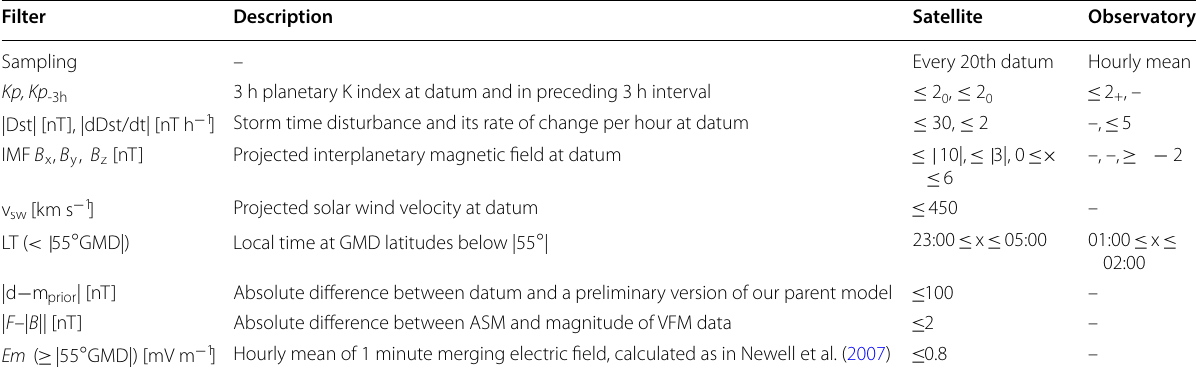
Table 1 Summary of data selection criteria for Swarm and ground observatory data